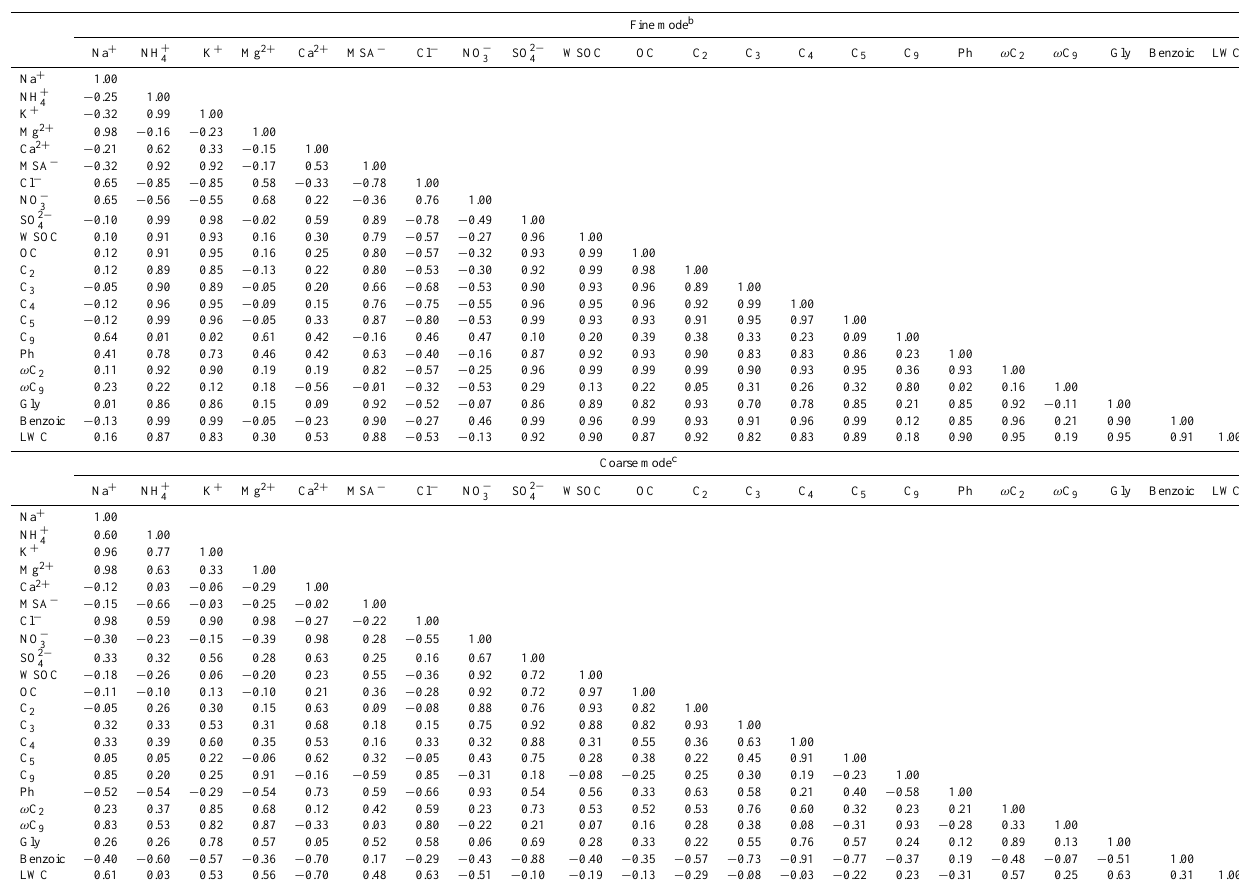
Table 3. Pearson correlation coefficients a ( r) matrix among the selected chemical species/components measured in the fine- and coarse-mode aerosols from Okinawa Island in the western North Pacific